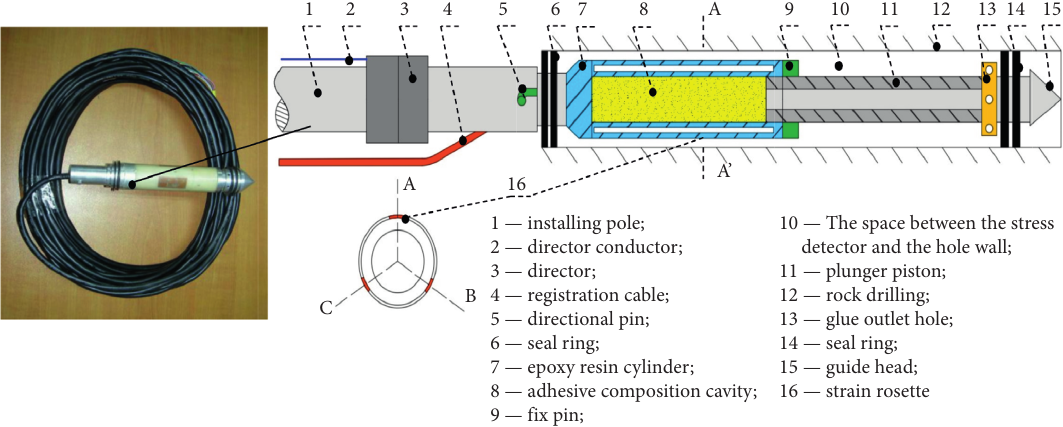
Figure 2: KX-81 hollow core inclusion triaxial geostress meter.